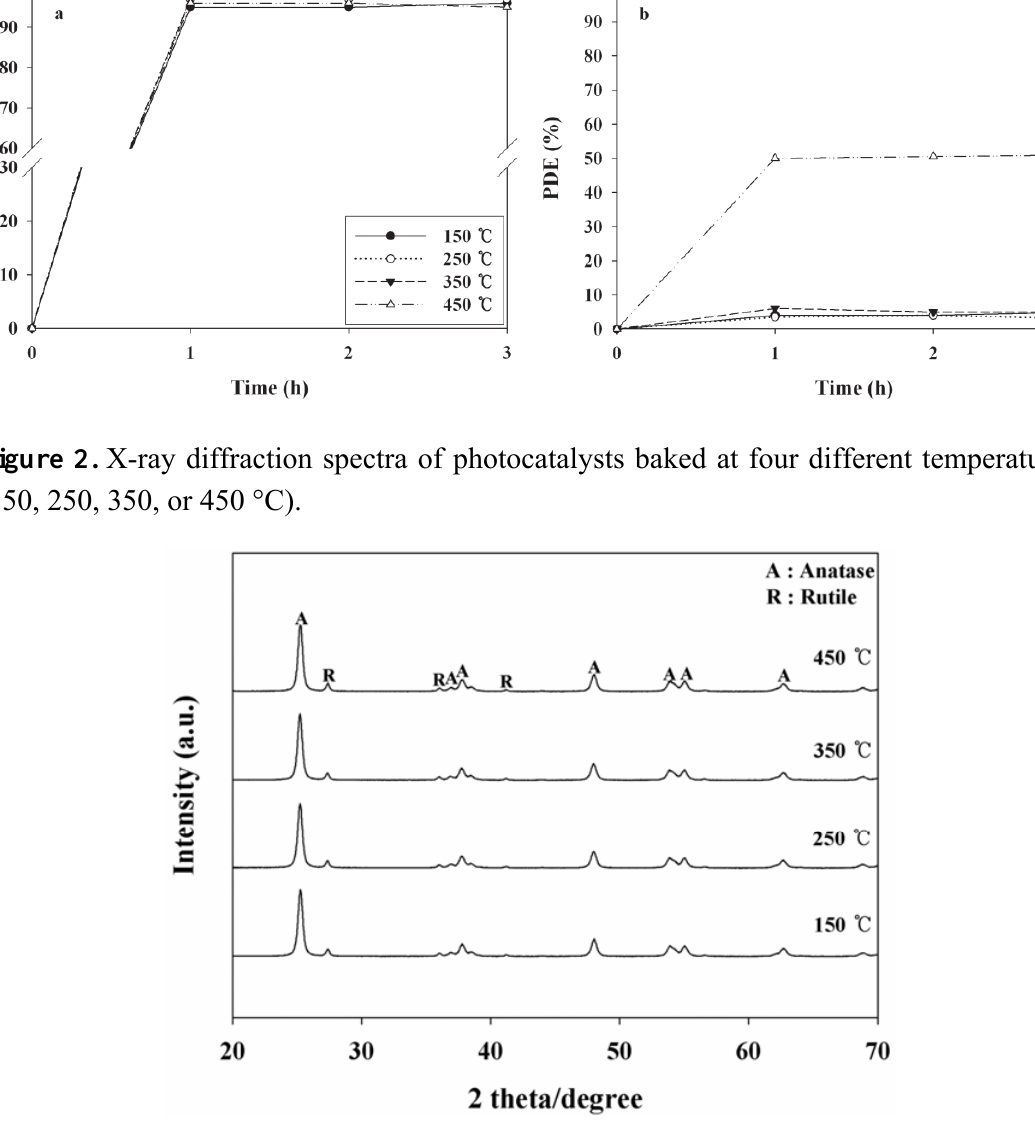
Table 1. The ratio of anatase at 2 θ = 25.2° to rutile at 2 θ = 27.4° according to baking